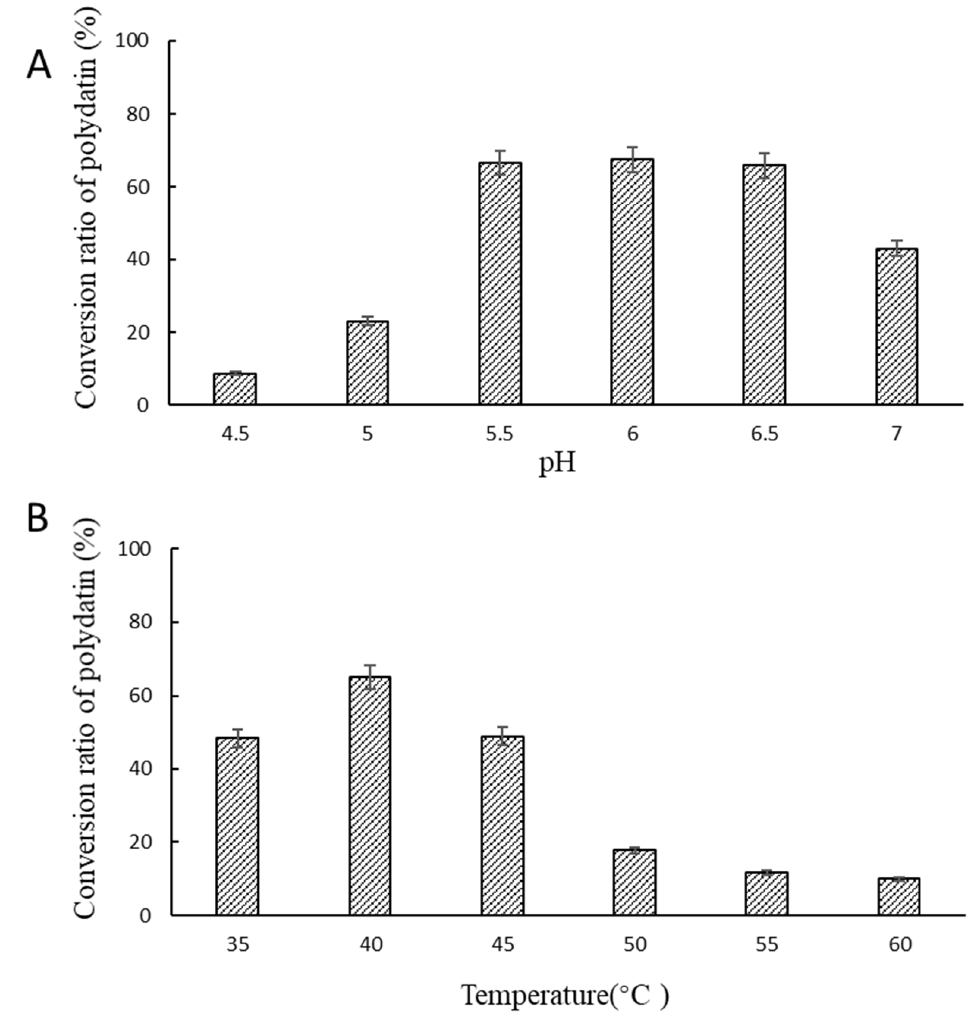
Figure 6. Effect of ( A ) pH and ( B ) temperature on the enzymatic activity of SpBGL1 in converting polydatin to resveratrol. The effect of pH was determined by incubating the enzyme with the substrate at 37 ◦ C at different pH values for 20 min; the effect of temperature was determined at pH 6.0 for 20 min.